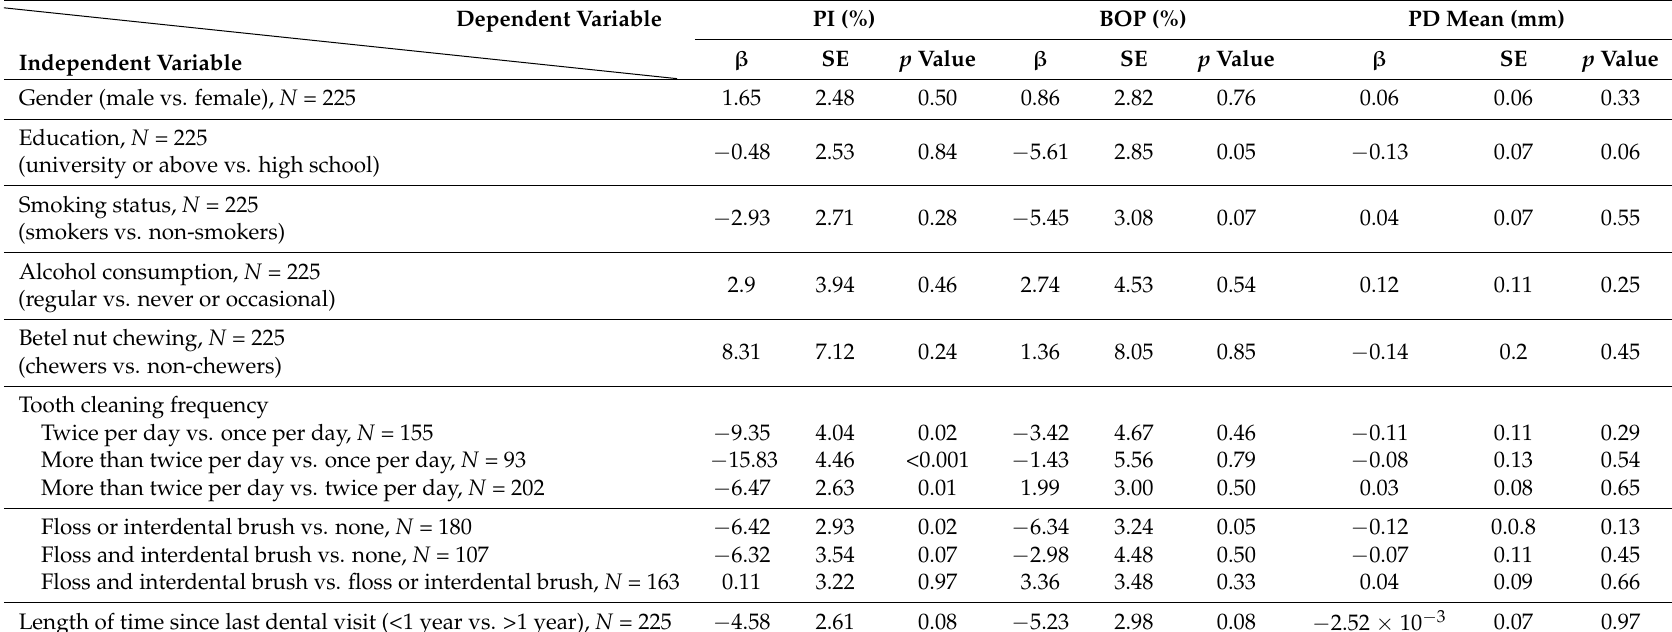
Table 3. Univariate regression analysis of conventional factors, oral health behaviors, salivary oxidative stress biomarkers, and clinical periodontal parameters. Dependent Variable PI (%) BOP (%) PD Mean (mm) β SE p Value β SE p Value β SE p Value Independent Variable Gender (male vs. female), N =